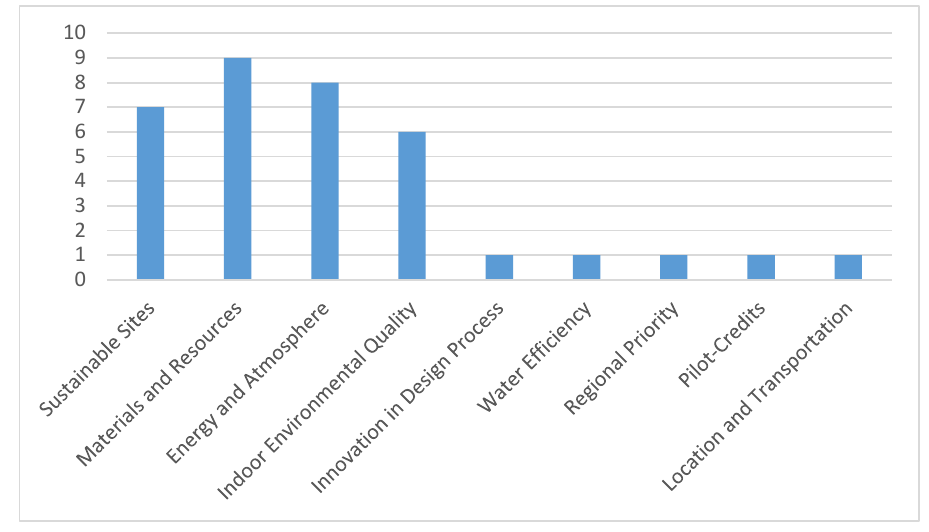
Figure 6. Addressed LEED categories.